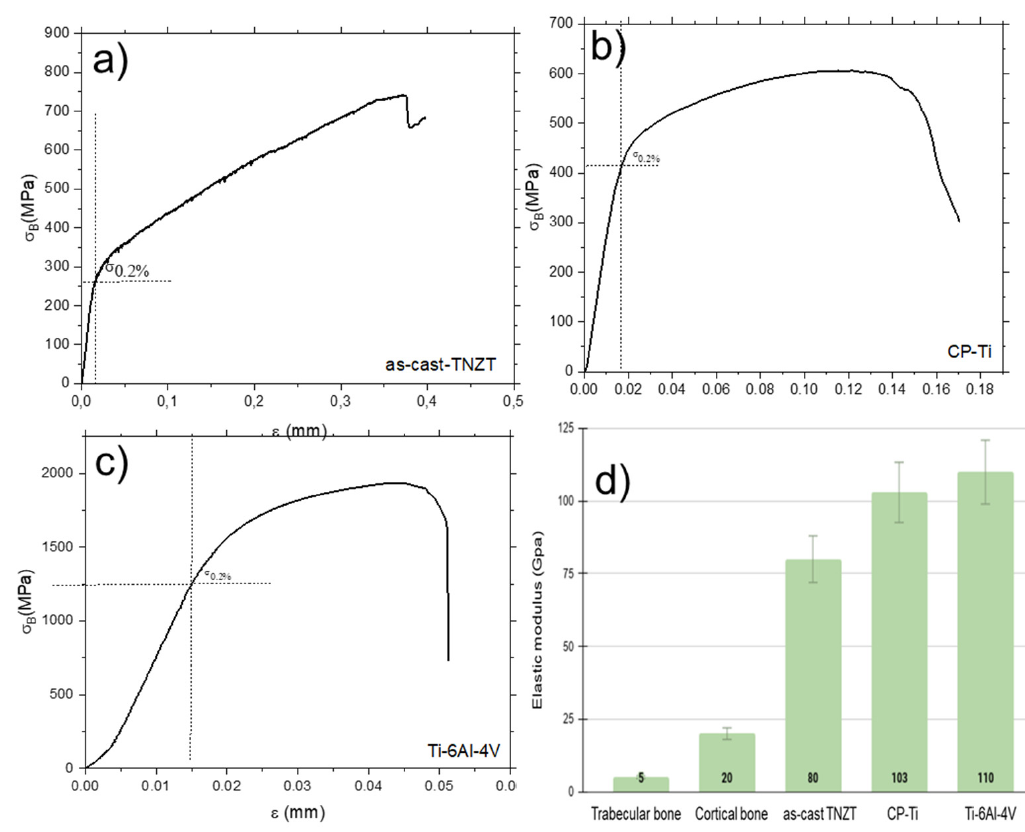
Figure 6. Bending stress–strain curves of as-cast TNZT ( a ), CP-Ti ( b ) and Ti-6Al-4V ( c ). A comparison of the elastic modulus to them and to bone ( d ) comparison of elastic modulus of as-cast with CP-Ti, Ti-6Al-4V and bone tissue, obtained by ultrasound.